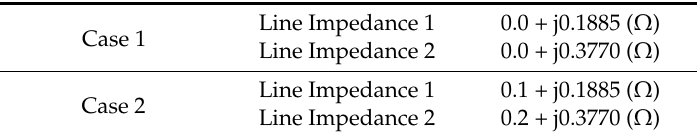
Table 3. Scenario of line impedance and simulation.